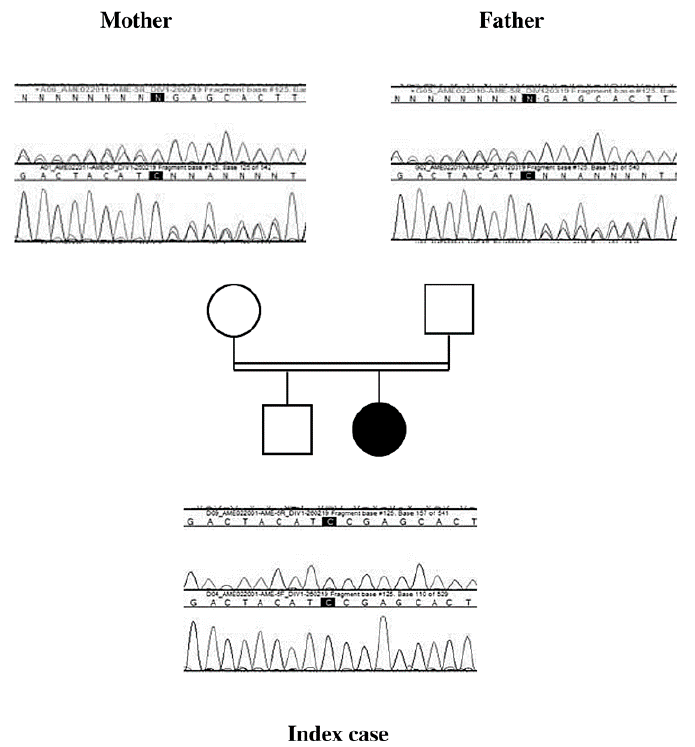
Figure 5. The chromatographic profile of each parent shows a superposition of the genomic sequences of the two alleles, one allele wild-type and the second with the mutation at position c.900, confirming the heterozygous status. Index case chromatogram shows only one genomic sequence, confirming the homozygous status for the pathogenic variant c.[900dup];[900dup];p.[(Glu301Argfs*56); (Glu301Argfs*56)].